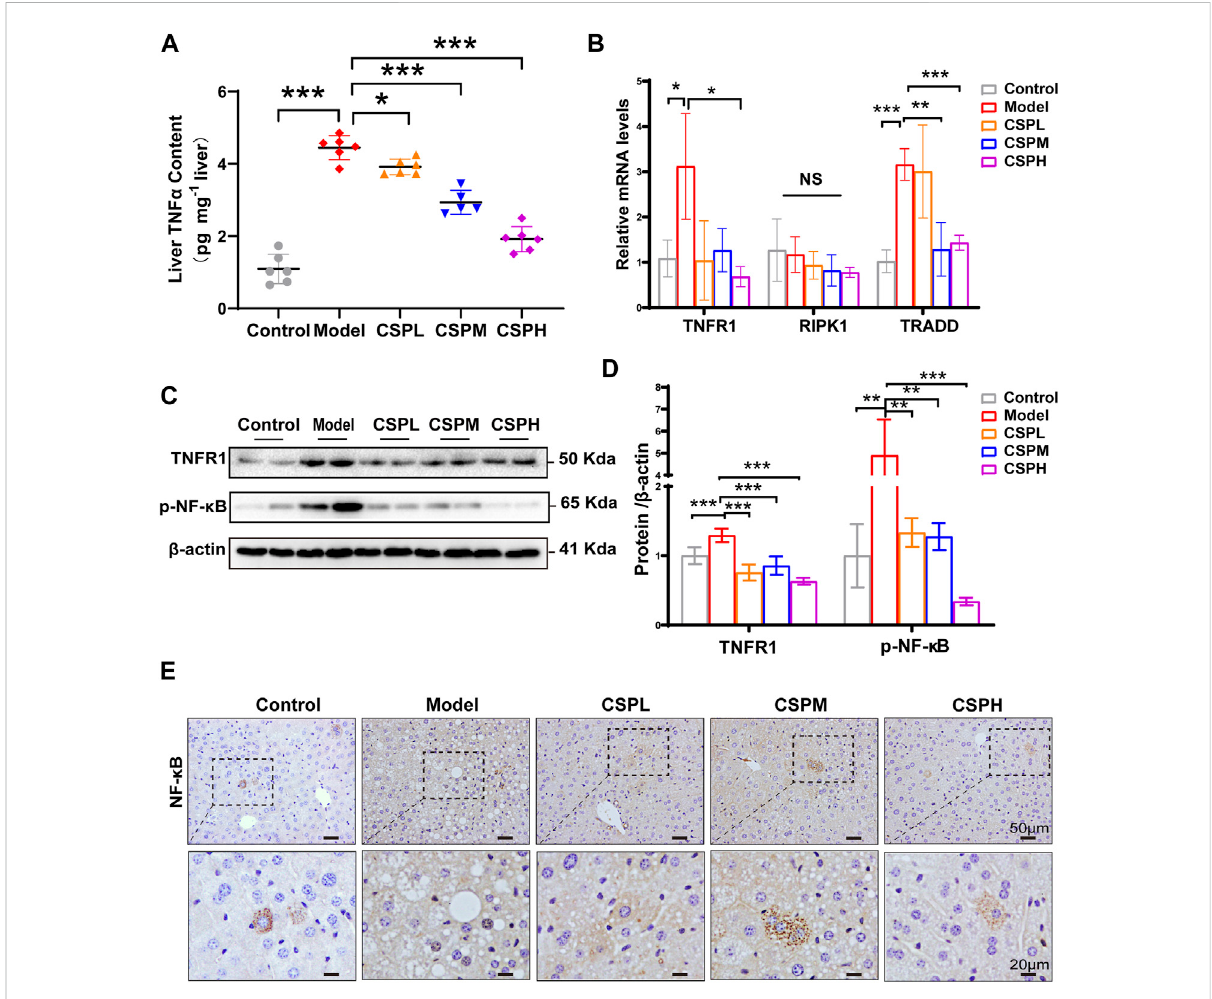
FIGURE 7 CSPinhibited theexpressionofTNF α and TNFR1andloweredtheligand availability ofTNFR1intheliversofmicewithHFHFD plusCIS. (A) TNF α content in liver assessed by ELSA assay; (B) The mRNA expression levels of TNFR1, RIPK1, and TRADD in the liver measured by RT-PCR analyses; (C) and (D) The protein expression levels of p-NF- κ B and TNFR1 in the TNF signaling measured in the liver; (E) Representative images of immunohistochemical staining of NF- κ B in liver sections (scale bar: 50 and 20 μ m). Data (A,B – D) are presented as the means ± s.d. NS = no signi fi cant difference, * p < 0.05, ** p < 0.01, *** p < 0.001, n = 5-6 samples per